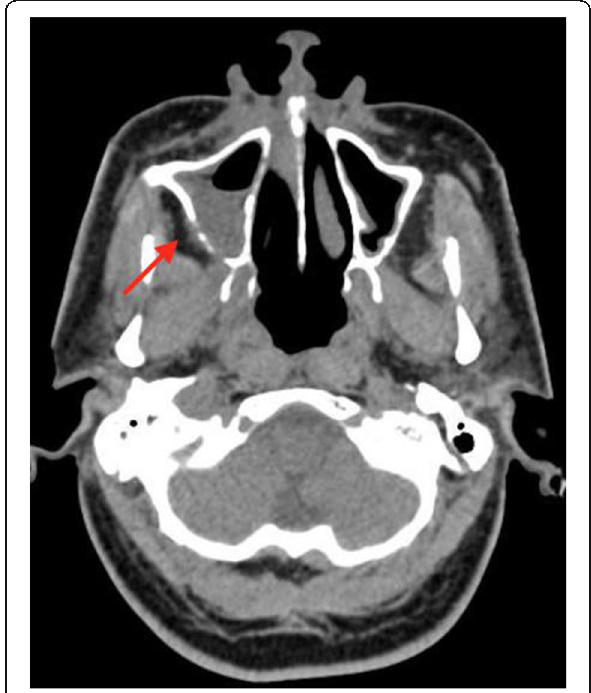
Fig. 4 Axial non-contrast CT shows infiltration of the right retroantral fat plane (arrow) indicating invasive disease extending through the posterior wall of the right maxillary